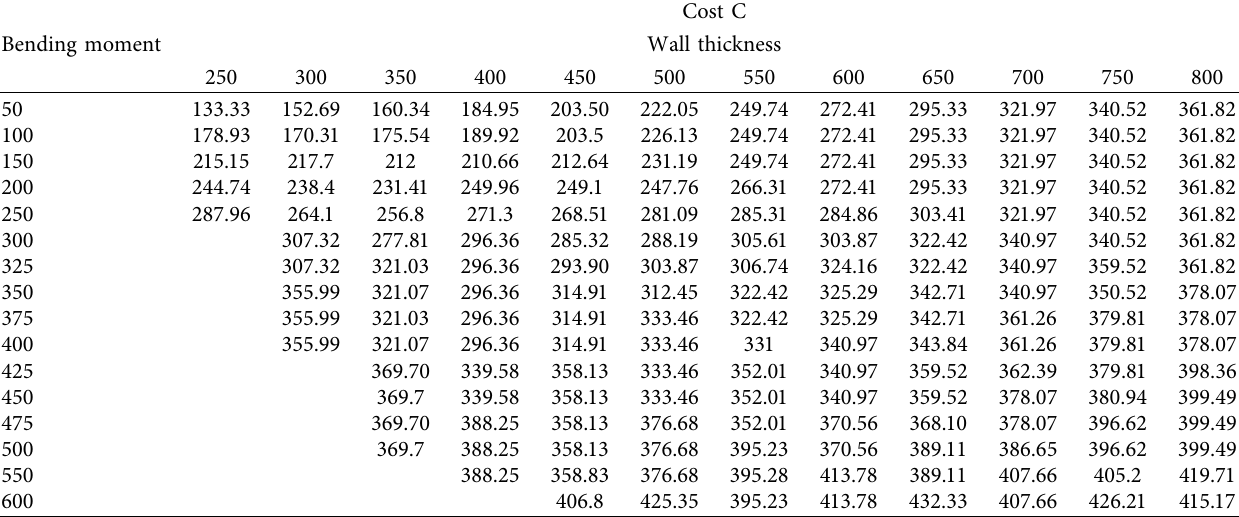
Table 7: Wall costs per unit area at different bending moments